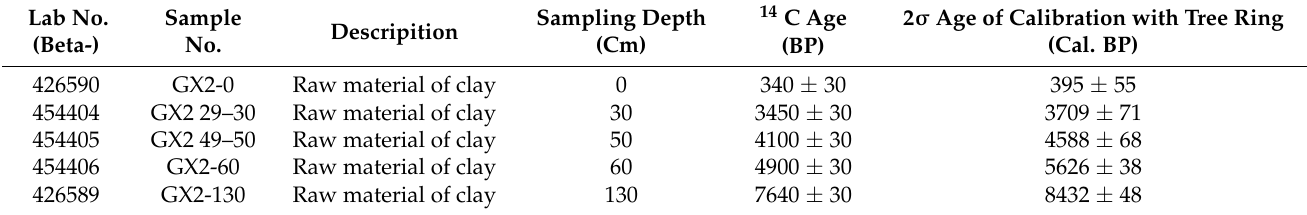
Table 1. Sediment AMS 14 C dating results of GX2 section.